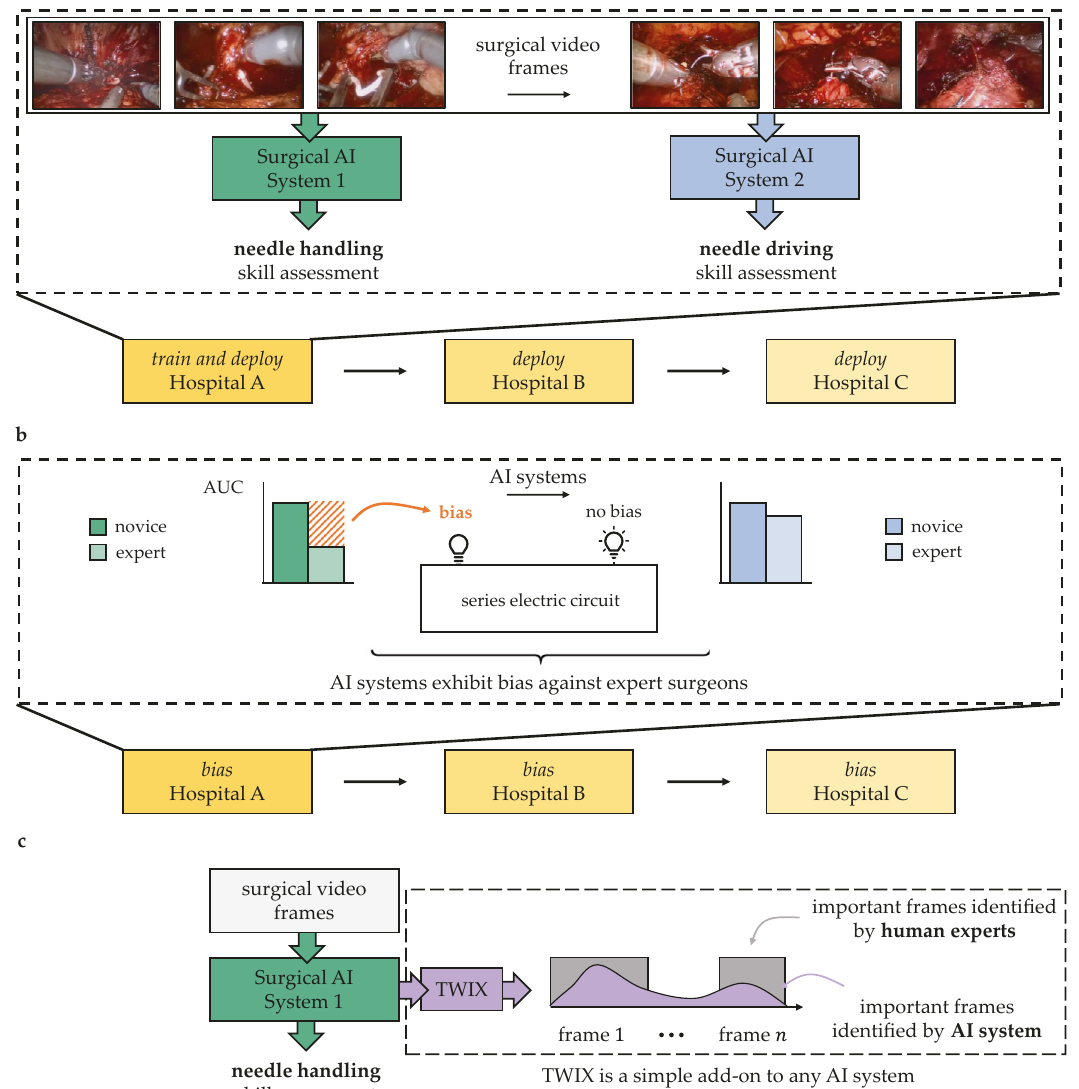
Fig. 1 Mitigating bias of multiple surgical AI systems across multiple hospitals. a Multiple AI systems assess the skill-level of multiple surgical activities (e.g., needle handling and needle driving) from videos of intraoperative surgical activity. These AI systems are often deployed across multiple hospitals. b To examine bias, we stratify these systems' performance (e.g., AUC) across different sub-cohorts of surgeons (e.g., novices vs. experts). The bias of one of many AI systems is akin to a light bulb in an electric circuit connected in series: similar to how one defective light bulb leads to a defective circuit, one biased AI system is suf fi cient to disadvantage a surgeon sub-cohort. c To mitigate bias, we teach an AI system, through a strategy referred to as TWIX, to complement its skill assessments with predictions of the importance of video frames based on ground-truth annotations provided by human